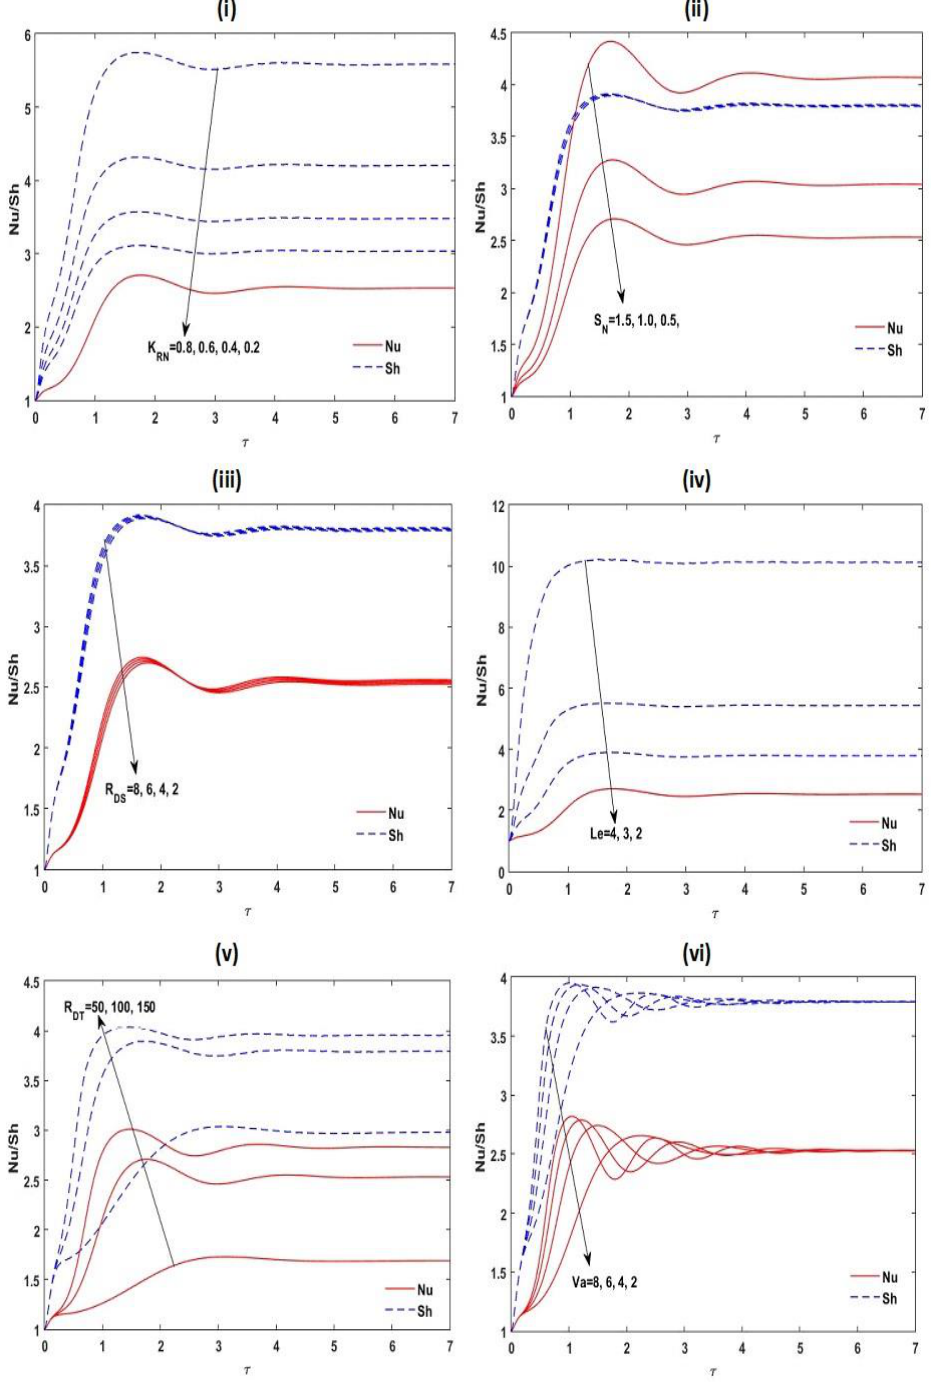
Figure 10. Disparity of the unsteady Nu and Sh with (cid:101) τ for different values of K RN , R DS , Le , R DT , and Va at Le = 2, m = 1.5, A = 1, R DS = 3, S N = 0.5, γ = 0.5, K RN = 0.5, and Va = 3. The convective steady mass transfer increased with increasing K RN , R DS , Le , and A for the slender enclosure ( A < 1 ) , while it decreased with A for rectangular enclosure A . From Figure 9, it is also found that increases in the values of S N , R DS , and A for the slender enclosure ( A < 1 ) amplify the convective heat transport in the scheme, while for a rectangular enclosure ( A > 1 ) , convective heat transport decreases with A